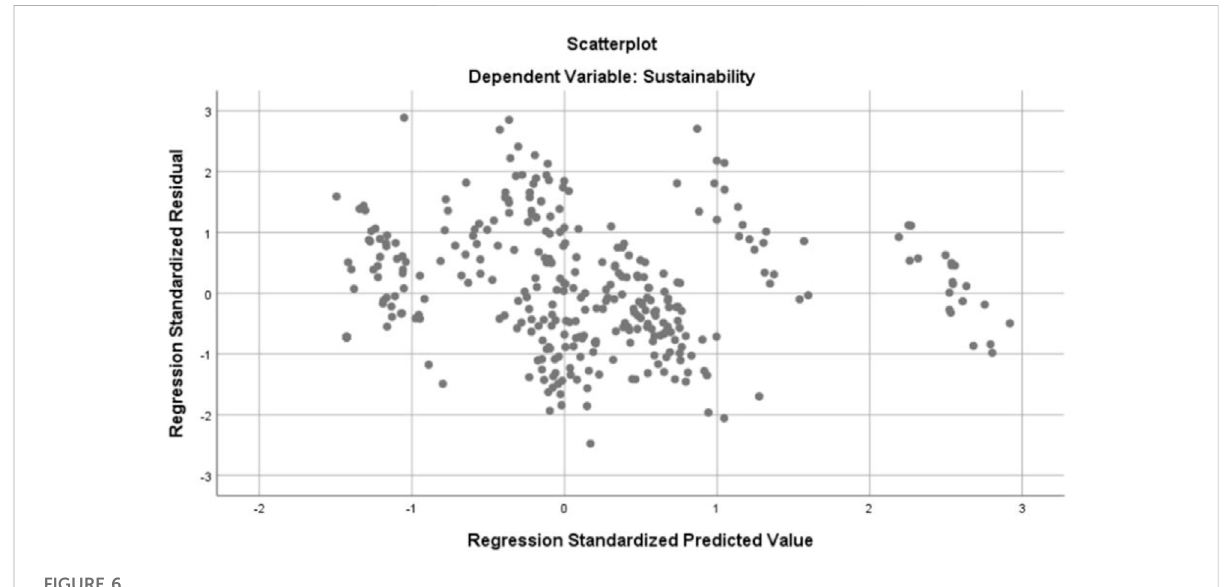
FIGURE 6 Regression ’ s scatter plot for CCD index under GC1 in the energy